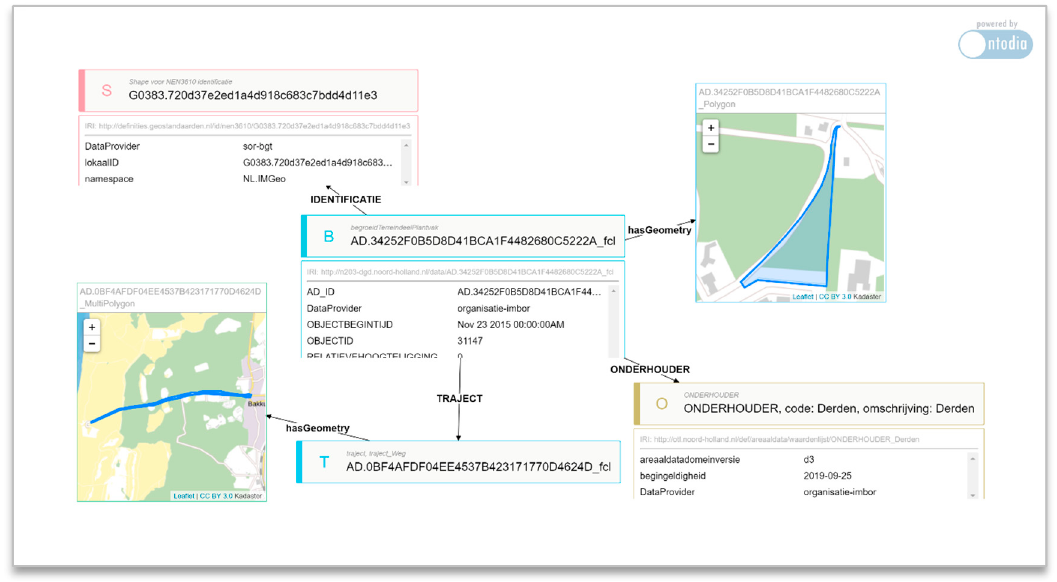
Figure 4. Ontodia User Interface based on Example Dataset.